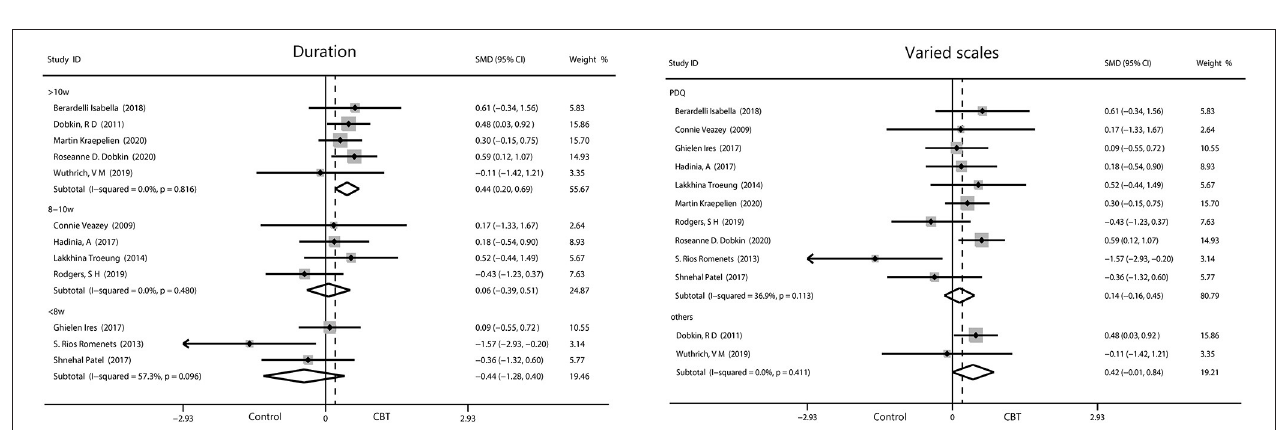
FIGURE 8 | Forest plot of random effects model meta-analysis of the effect of CBT on subgroups of QOL. CBT, cognitive behavioral therapy; QOL, quality of life; PDQ, Parkinson’s Disease